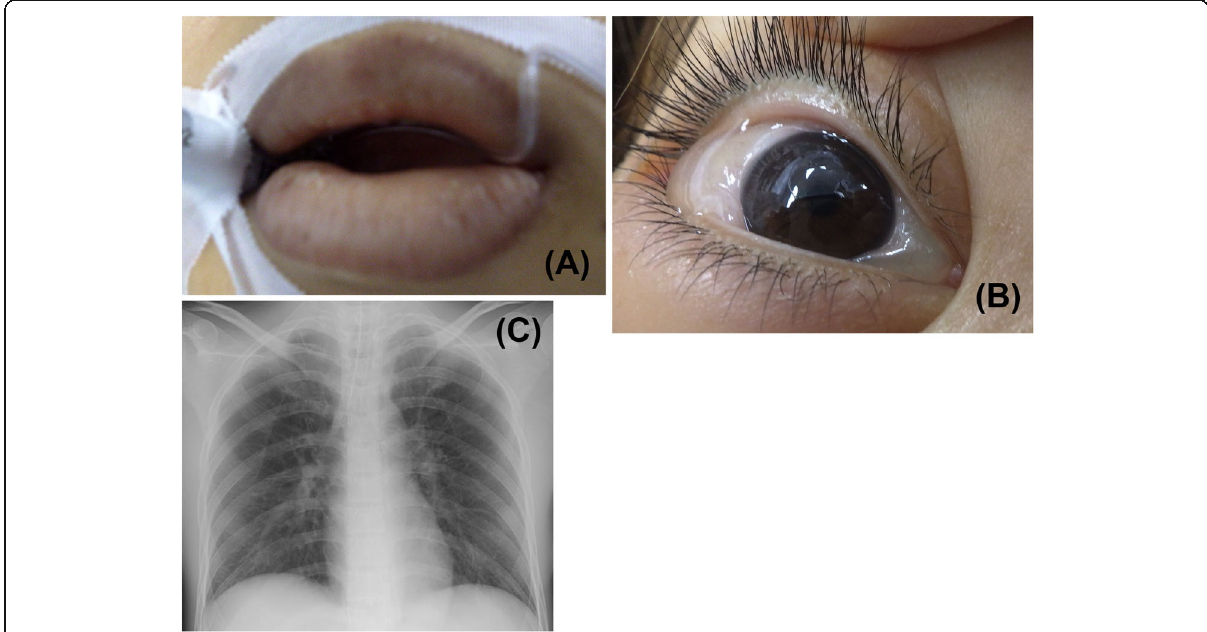
Fig. 1 Edema of lips ( a ) and conjunctiva ( b ), and chest X-ray ( c ) at the end of the